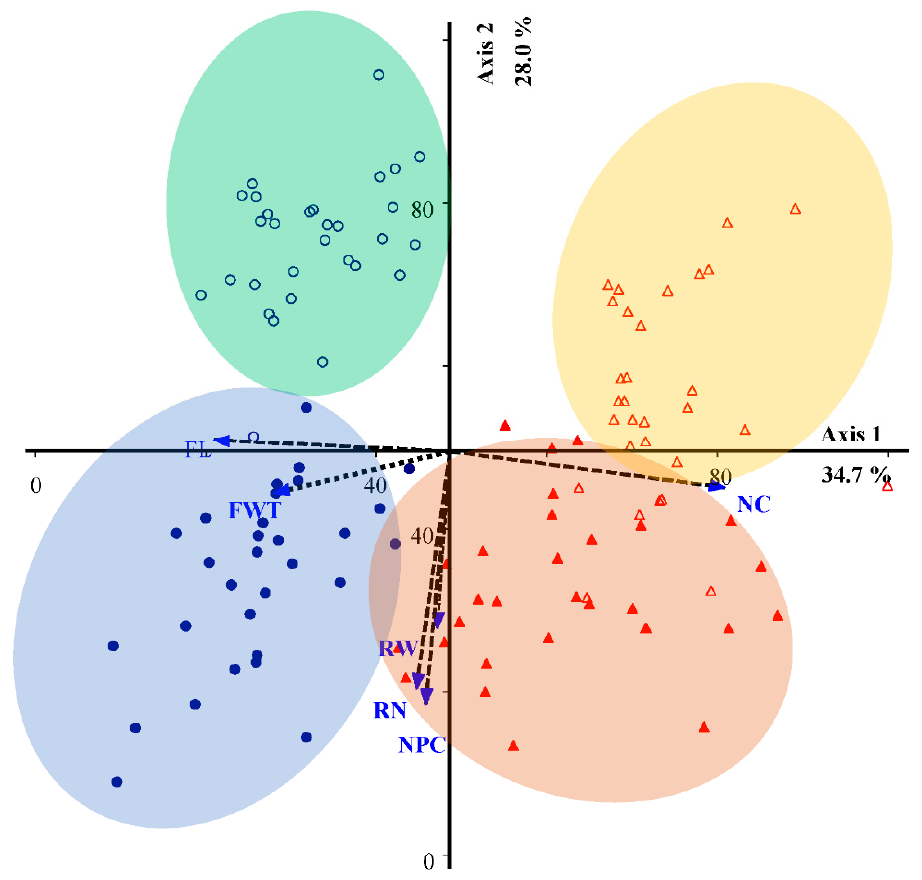
Figure 3. Principal component analysis (PCA) biplot based on correlation matrix of declined and healthy Quercus brantii . ▲ Declined trees from Dareh‑shahr; △ healthy trees from Dareh‑shahr; • declined trees from Ilam; ◦ healthy trees from Ilam. Arrows with narrow angles from the axis indicate strong correlations, while a right angle indicates no correlation. The length of the arrow is a measure of the relative importance of the variables. FL, fiber length; FWT, fiber wall thickness; NPC, number of axial parenchymal cells; RN, ray number; RW, ray width; NC, number of